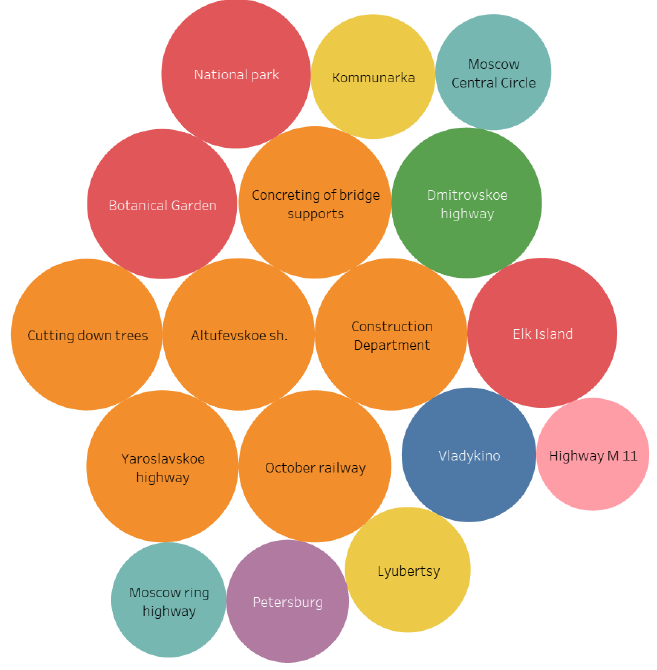
Figure 4. Core of the semantic network.